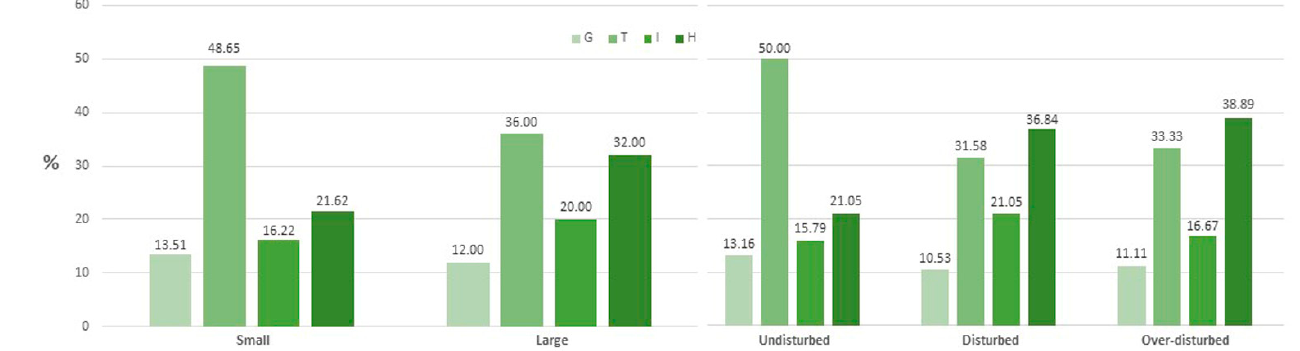
Figure 1. Percentage cover of geophytes (G), therophytes (T), hydrophytes (I), and hemicrypto- phytes (H) in small and large SWEs ( left ) and in undisturbed, disturbed, and over-disturbed plots ( right ).